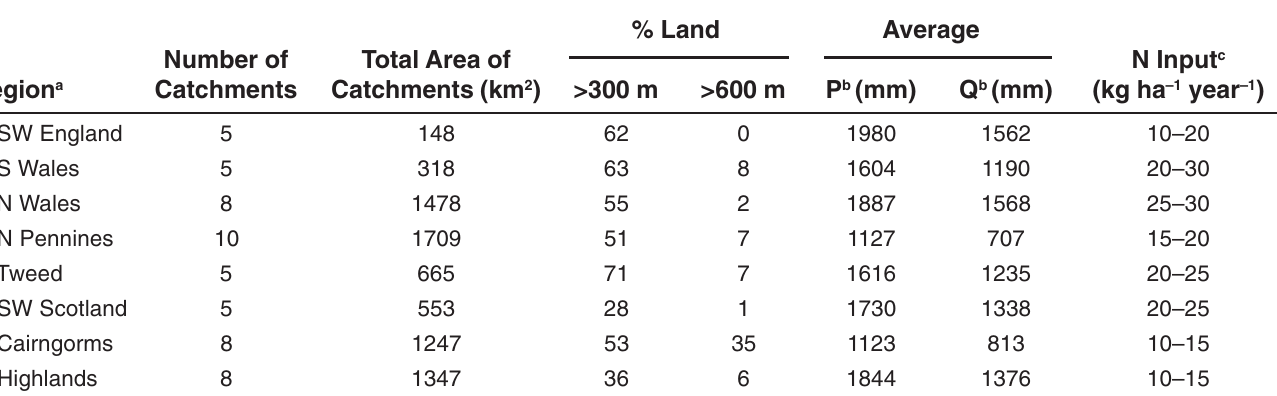
Characteristics of the Study Catchments in the Different Upland Regions of